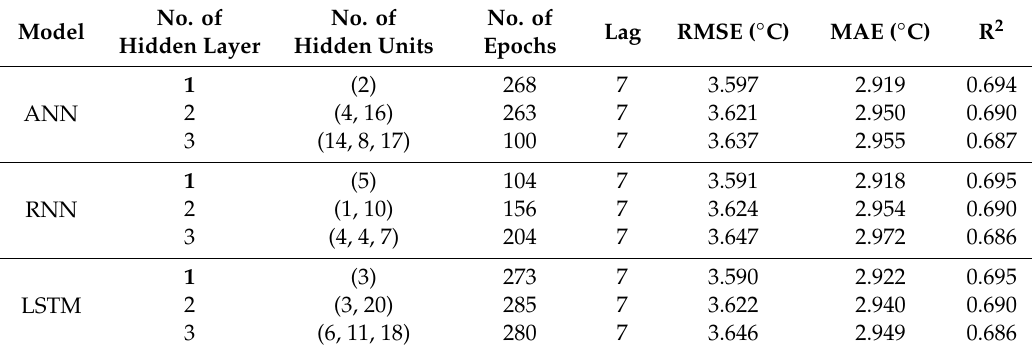
Table 3. The performance measure of models for spring.